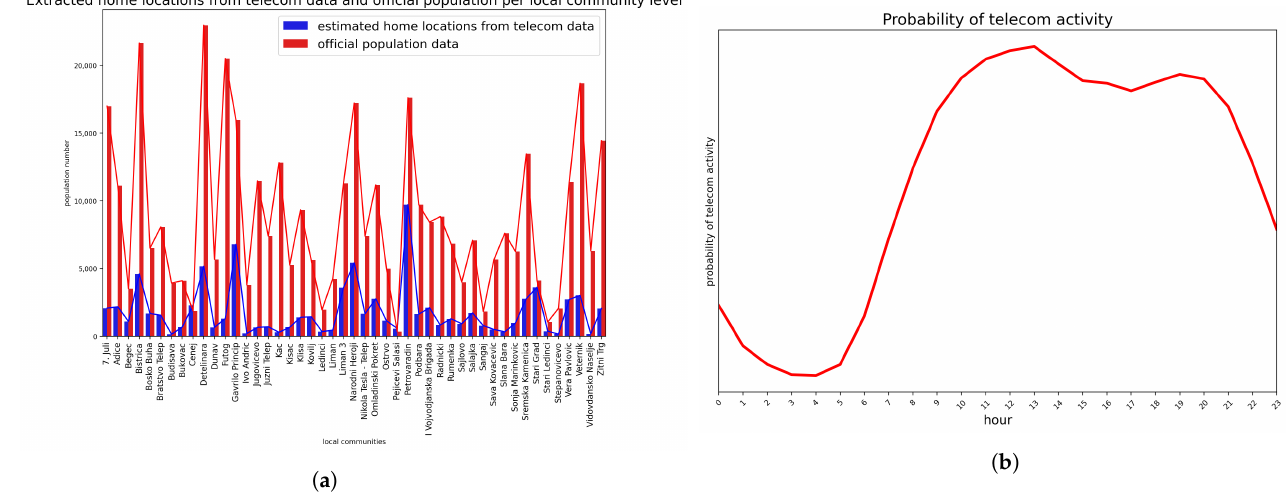
Figure 3. Telecom output. ( a ) The number of origin (home) locations extracted from telecom data compared to census data at local community level. ( b ) Extracted probability of temporal telecom activity across hours in a working day for the whole